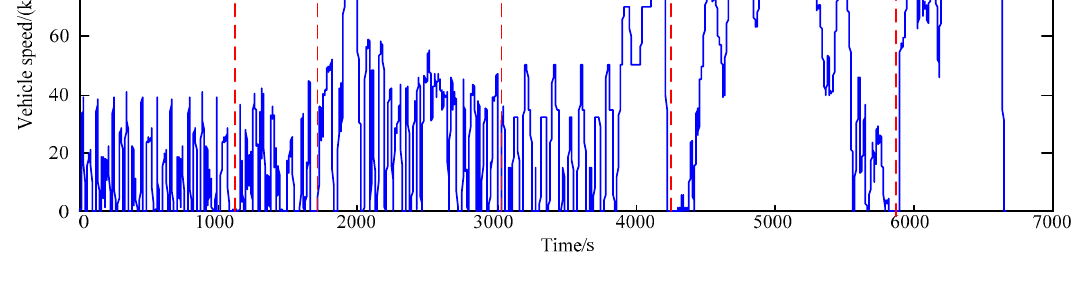
Figure 6. Sample driving cycle. Table 5. Three cluster centers.